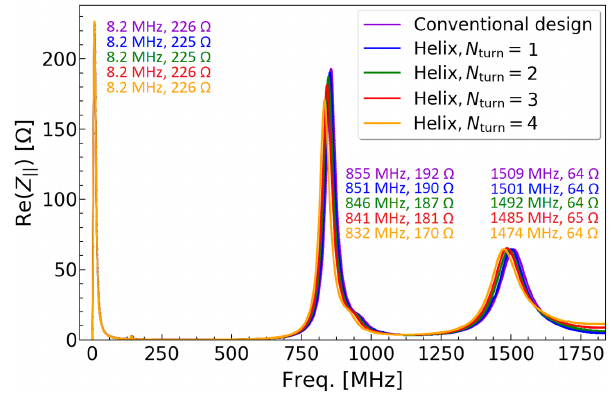
FIG. 8. Real part of the longitudinal impedance of the helical and conventional beam screen design (cut-down models).